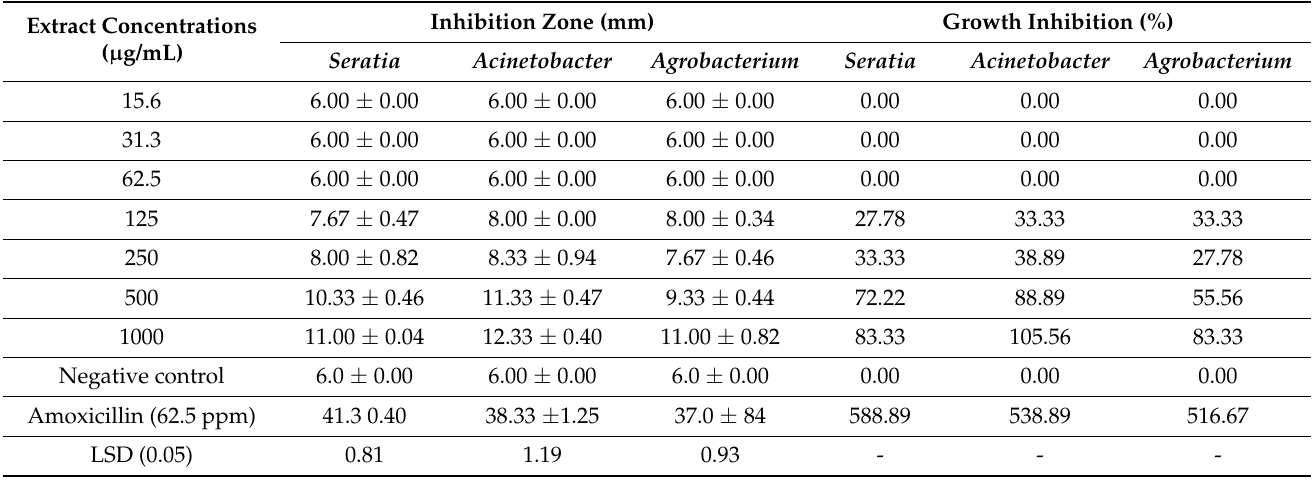
Table 4. Antibacterial activities of A. vulgaris root extract against Serratia marcescens, Acinetobacter johnsonii and Agrobacterium tumefaciens . Data are shown as mean ± SD, n = 3.